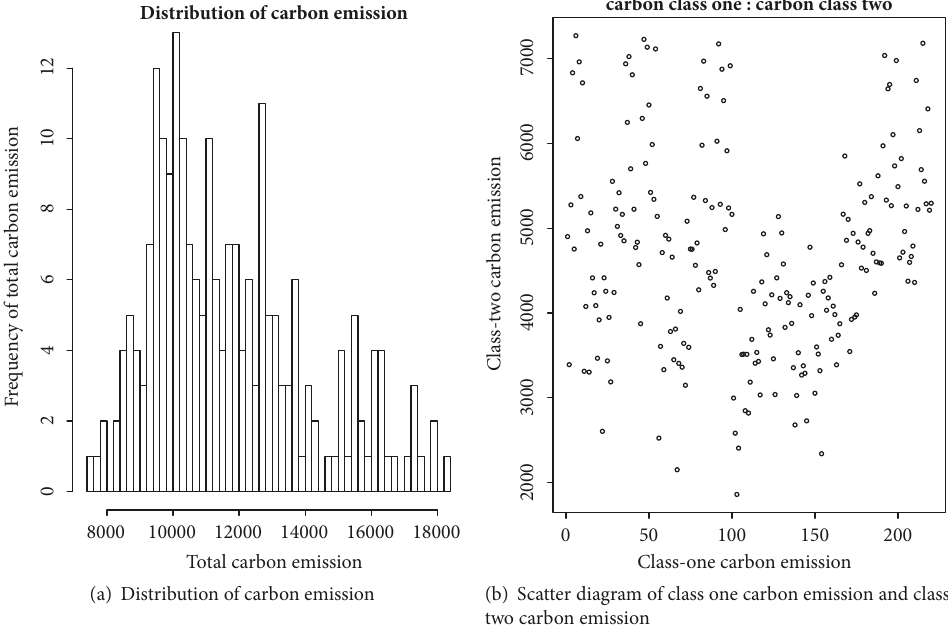
Figure 10: Distribution and scatter diagram of carbon emissions, S2.